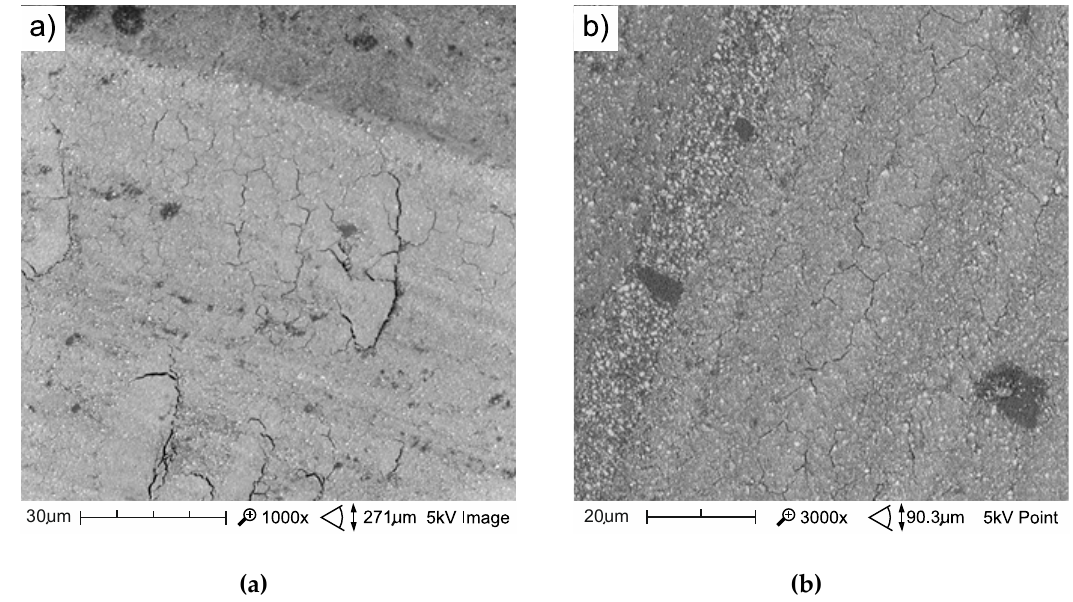
Figure 15. SEM images of a wear track of the composite Ex-flow (G) with aging only in AS at 37 ° C ( a ) and after 10 4 TCs ( b ).